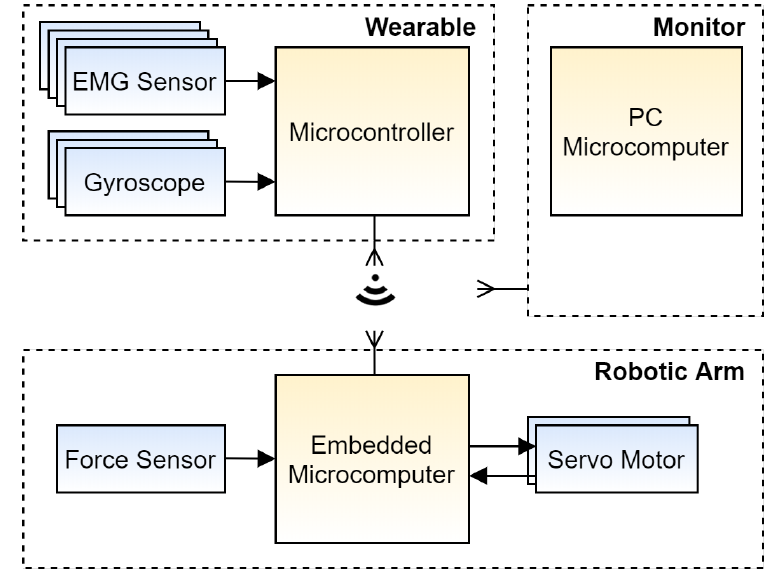
Figure 3. System